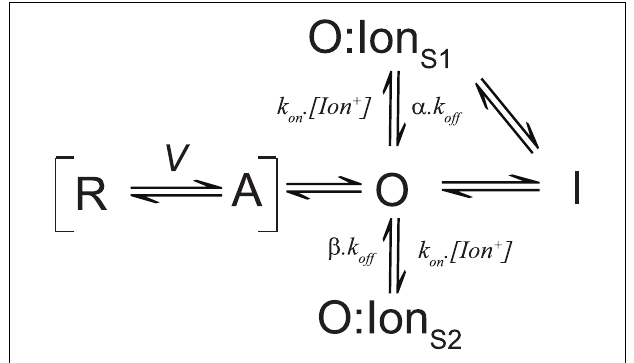
FIGURE 3 | State model summarizing the effects of intracellular ions on voltage sensor dynamics. The model is described in the